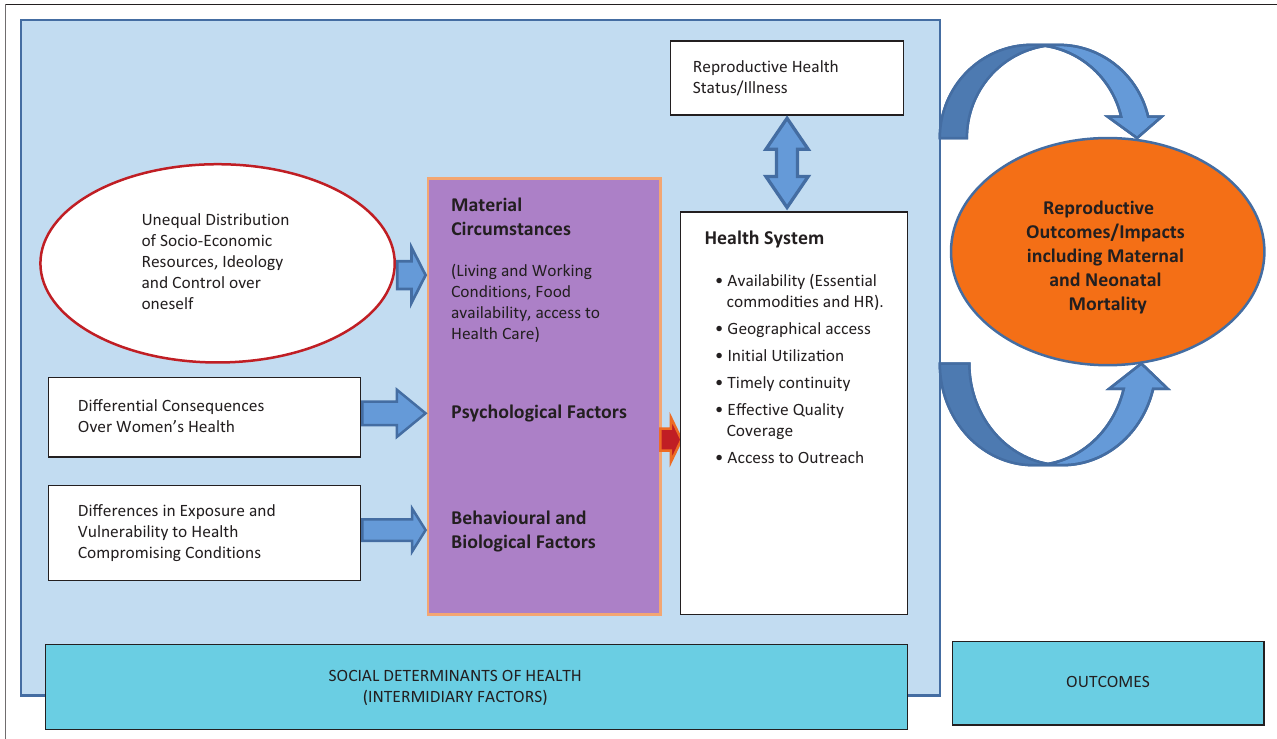
FIGURE 1: The Analytic Framework of the Social Determinants of Health in Relation To Maternal and Neonatal